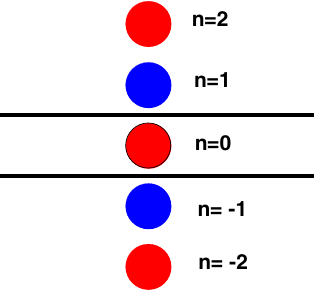
FIG. 3. Sequence of images of an infinitely long and uniform round beam centered between a pair of parallel plates. The image beams ( n ≠ 0 ) have the same shape and dimension as the source beam ( n ¼ 0 ).